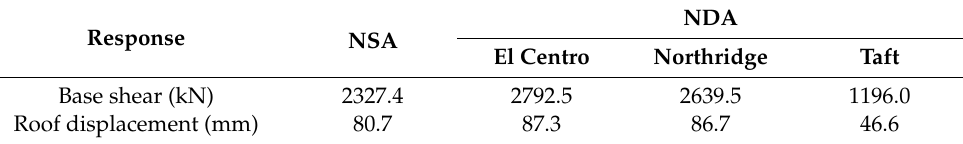
Table 3. Comparison of NSA and NDA results.